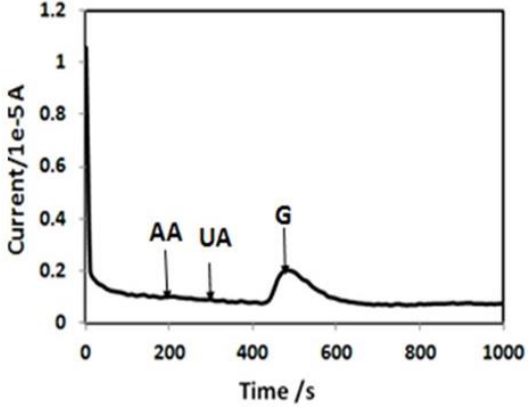
Figure 7. Chronoamperometric response of BP2 electrode biosensor to glucose, ascorbic acid (AA) and uric acid (UA) at a potential of 0.5 V (physiological level of AA and UA were added (0.1 mM for AA, 0.1 mM for UA) at the 100th and 200th second, respectively, and subsequently 1 mM of glucose was